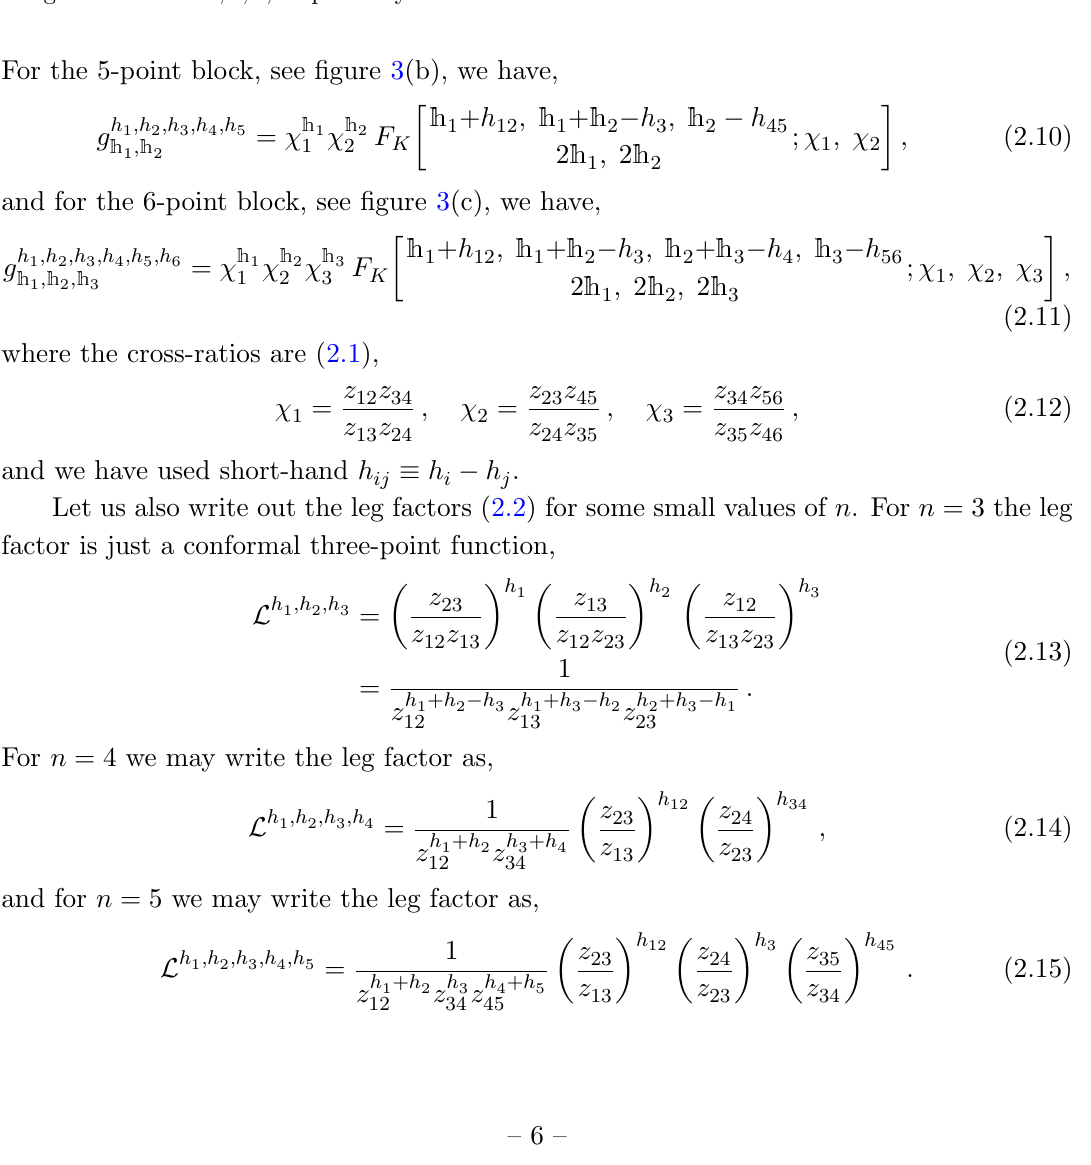
Figure 3. The (a) 4-point (b) 5-point (c) 6-point conformal partial waves. These are special cases of (cid:12)gure 2 for n = 4 ; 5 ; 6,